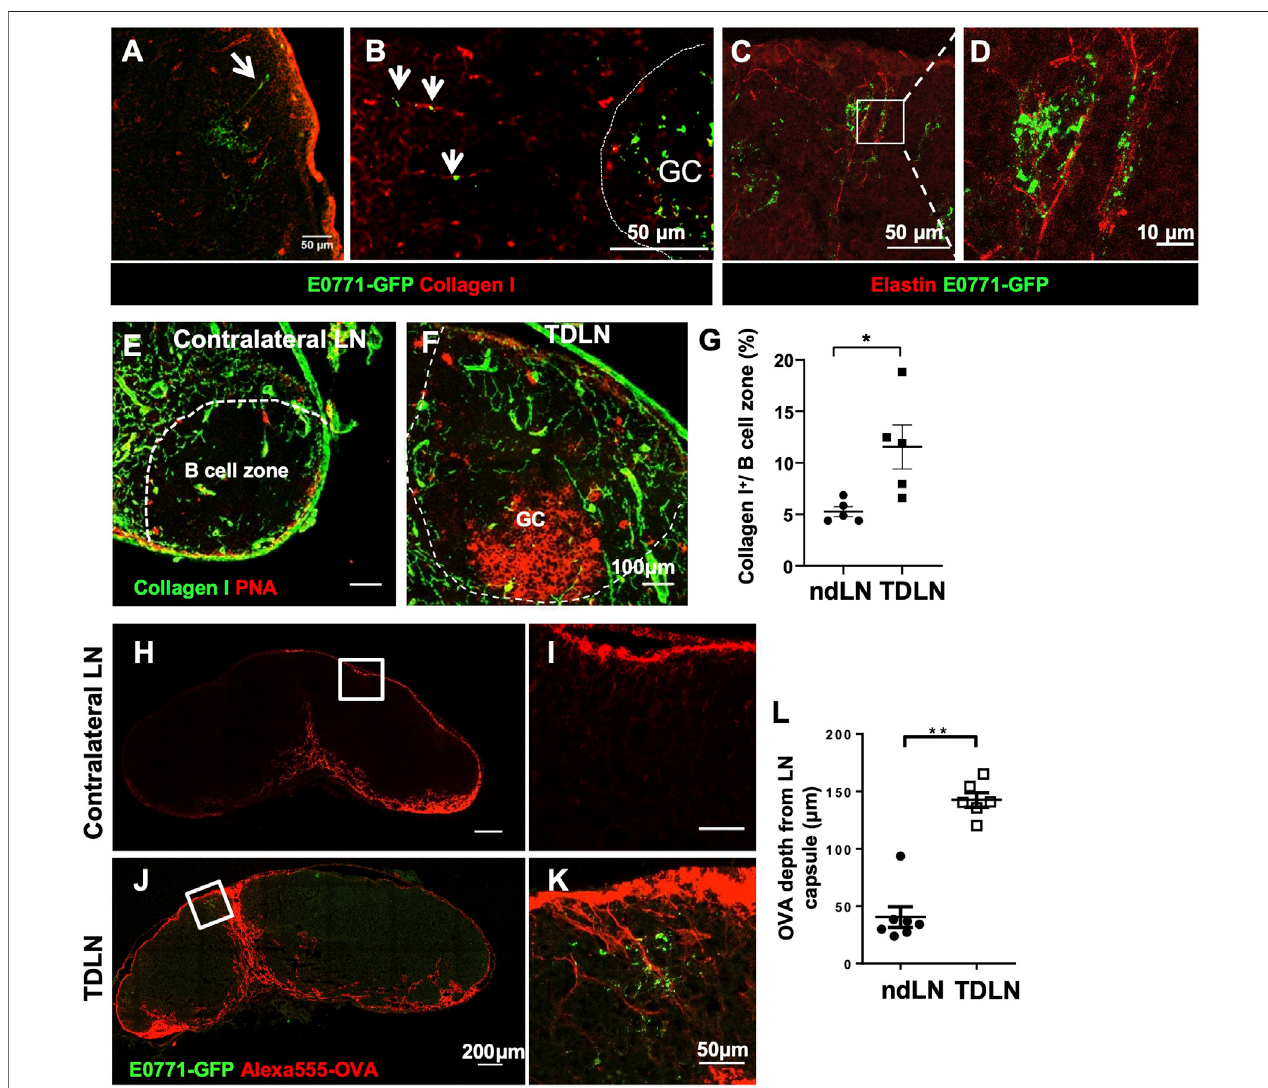
FIGURE3| Tumorgrowth reconstructs conduits tofacilitatesmallantigen entryintotheBcell zone andGCs. (A – D) Outside ofthe GCs,GFP wasassociated with Collagen I + (A,B) and Elastin + (C,D) conduits. n = 5. (E – G) Collagen I + conduits in the B cell zone were more abundant in the TDLN than the contralateral ndLN. Images arerepresentative of n =5pergroup, repeated twice.Quanti fi cation istheaverageofallBcellzonesper lymphnode sectionper mouse. Dataismean±SEM.* p < 0.05. Unpaired, parametric student ’ s t -test. (H – L) Alexa555-conjugated ovalbumin (OVA) penetrated deeper into the LN cortex toward GFP clusters in the GCs in the TDLNs. Data is mean ± SEM. ** p < 0.01. Mann-Whitney U test. Images are a representative of n = 5 – 7 per group, in two separated experiments. Image quanti fi cation is the average of three measurements per lymph node section per mouse.